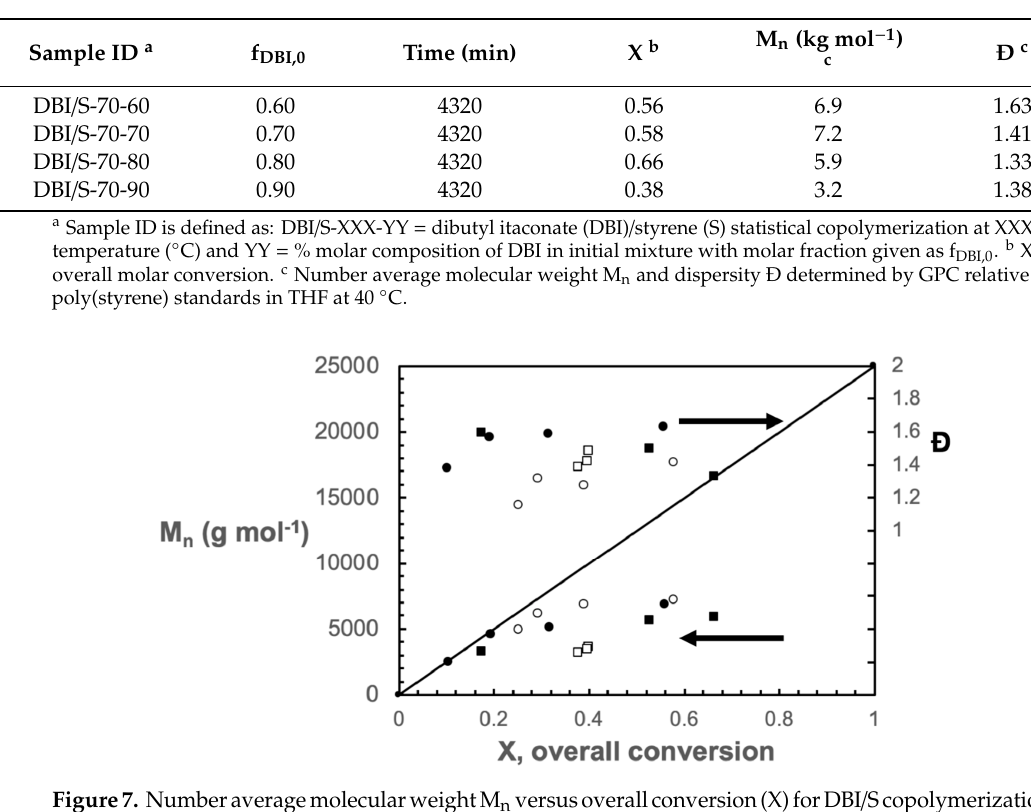
Table 4. Summary of dibutyl itaconate / styrene copolymerizations in 50 wt% dioxane solution at 70 ◦ C at di ff erent initial compositions.